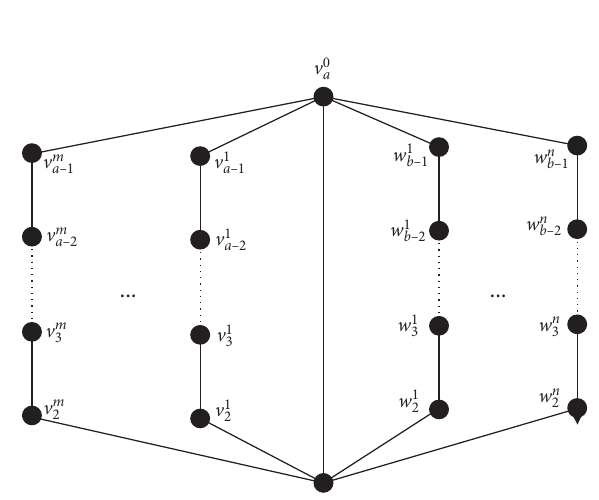
Figure 2: Graph B [( a , m ) , ( b , n ) , 2 ]